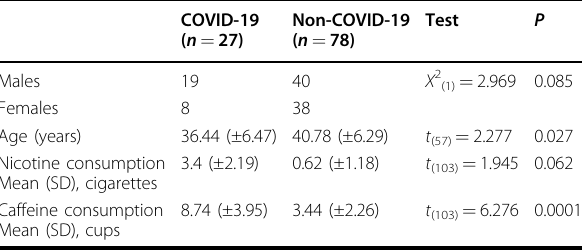
Table 1 Demographics and baseline